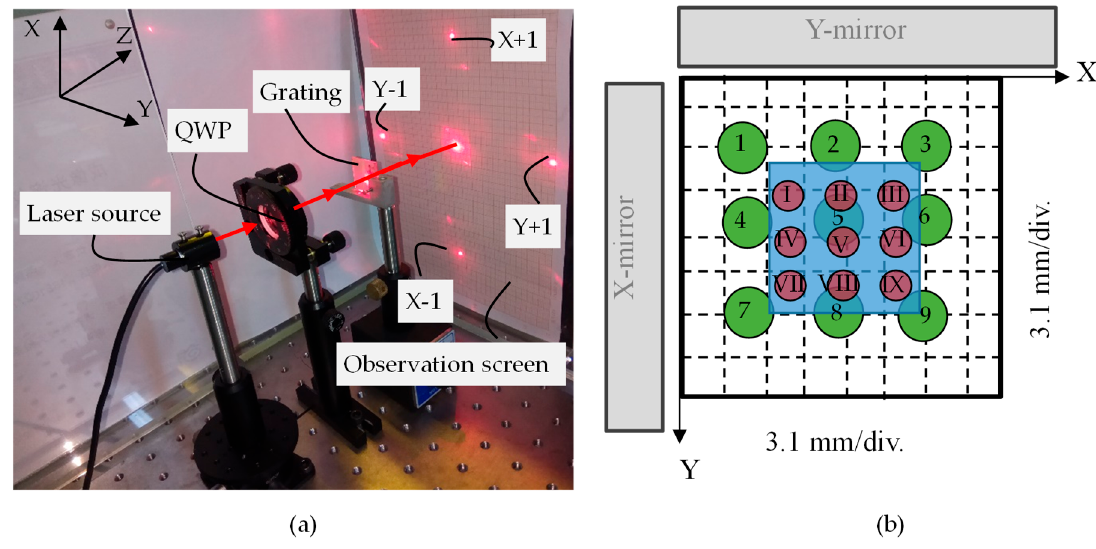
Figure 7. Diffraction efficiency testing setup ( a ) and measurement points on the grating surface ( b ). Table 1. Diffraction efficiency testing result of the grating fabricated without polarization. Points